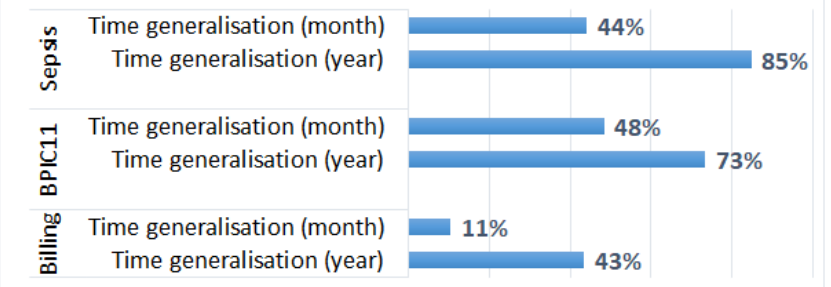
Figure 7. The impact of time generalisation on the results of process performance analysis: the absolute percentage differences between the average times between activities in the original log and the anonymised